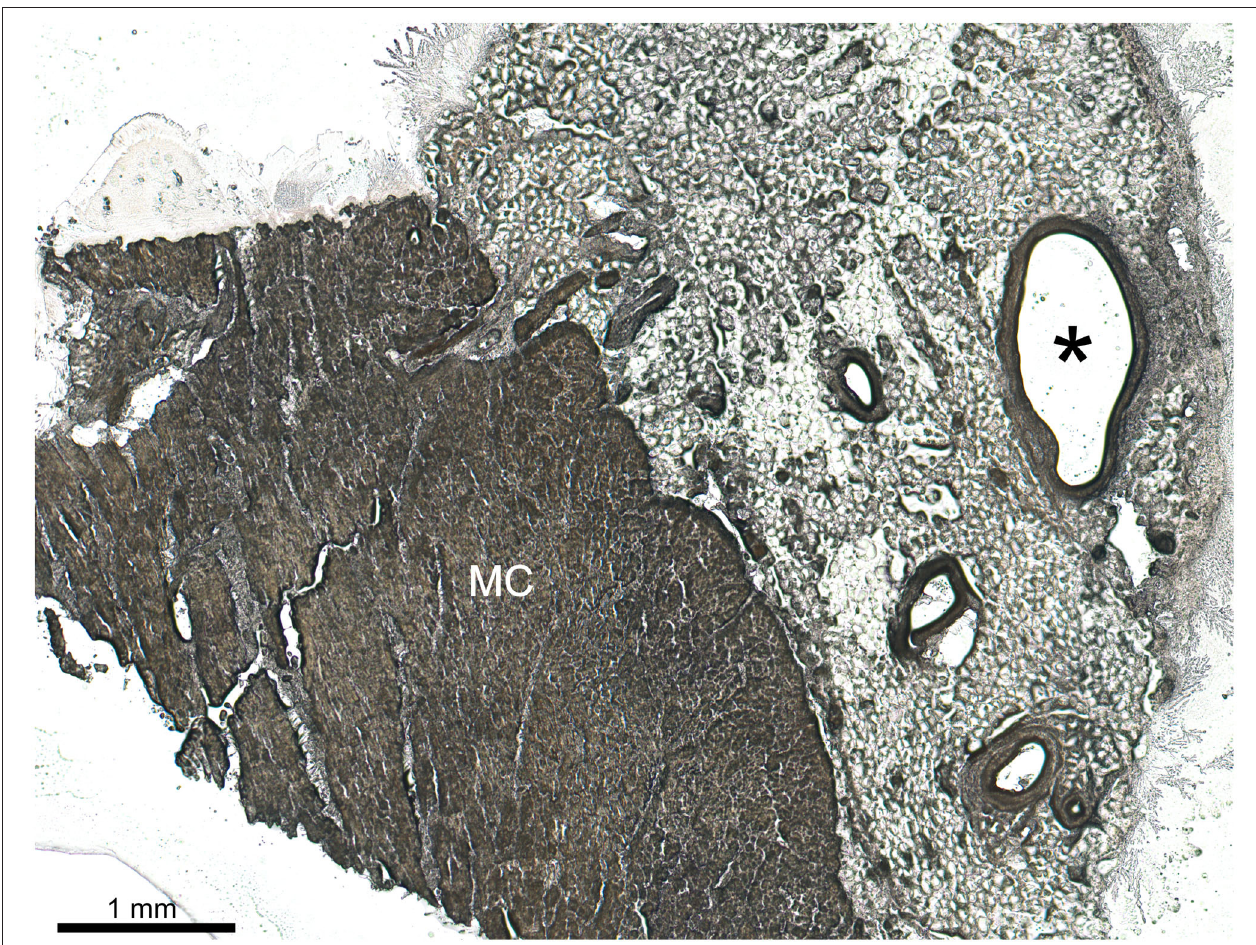
FIGURE 4 | Cryosection (50 µ m thick) of left posterior ventricular vein ( V. ventriculi sinistri posterior ; asterisk) embedded in epicardial adipose tissue and underlying left ventricular myocardium